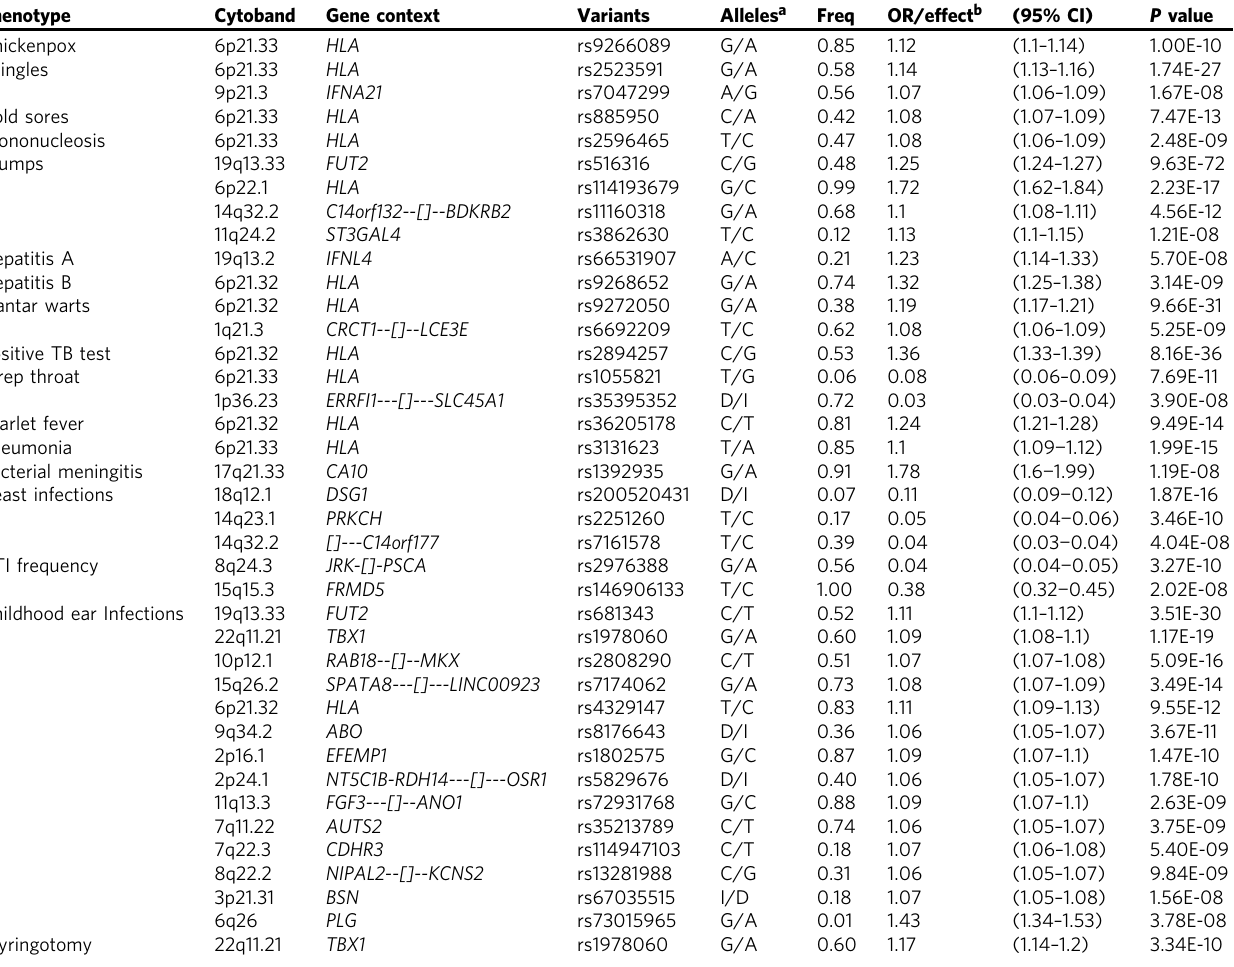
Table 2 Genome-wide signi fi cant associations for each disease part 1